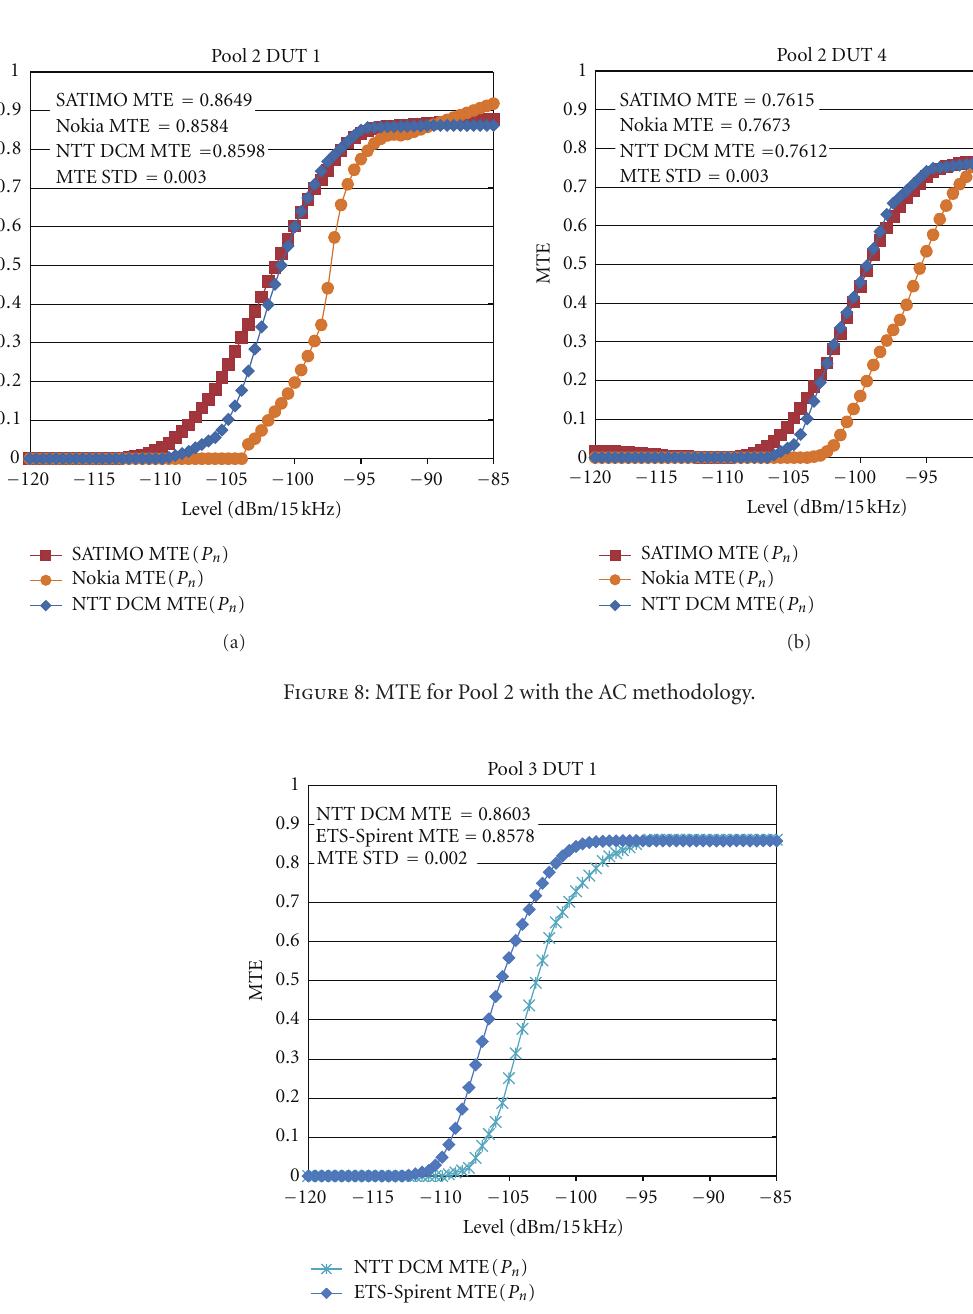
Figure 9: MTE for Pool 3 with the AC